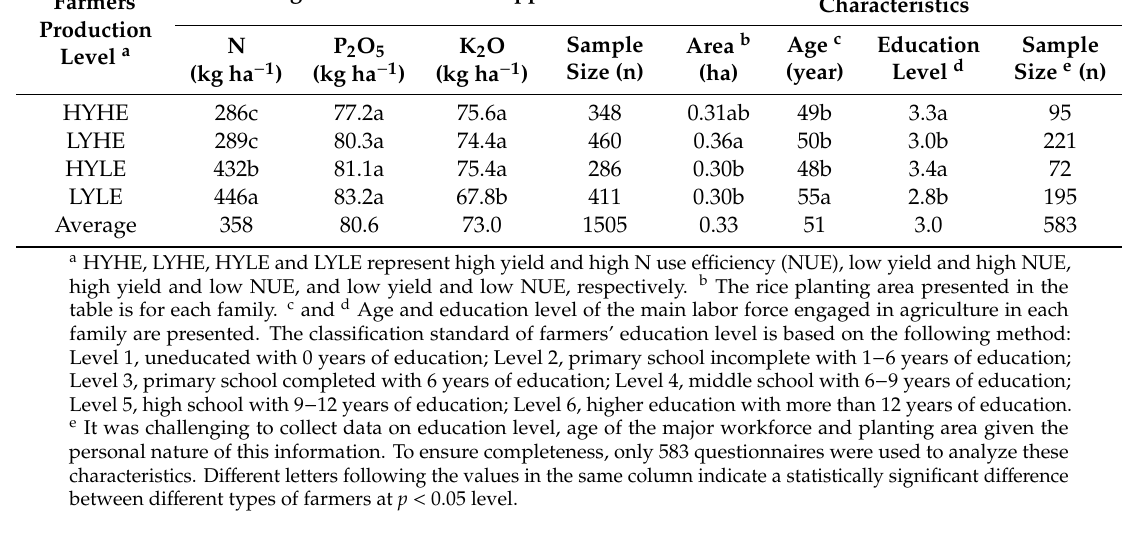
Table 4. Limiting factors a ff ecting rice yield and nitrogen use e ffi ciency in Jiangsu Province. Data from farm surveys conducted from 2008 to 2014.